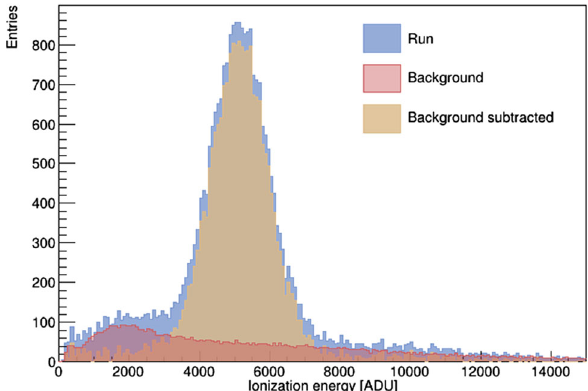
Fig. 3 Background subtraction for 1 . 5 keV electrons